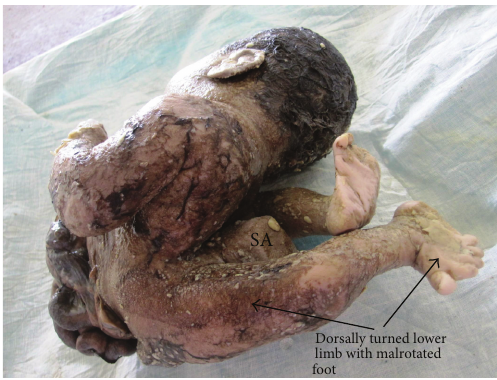
Figure 3: Showing dorsally rotated lower limbs and malrotated